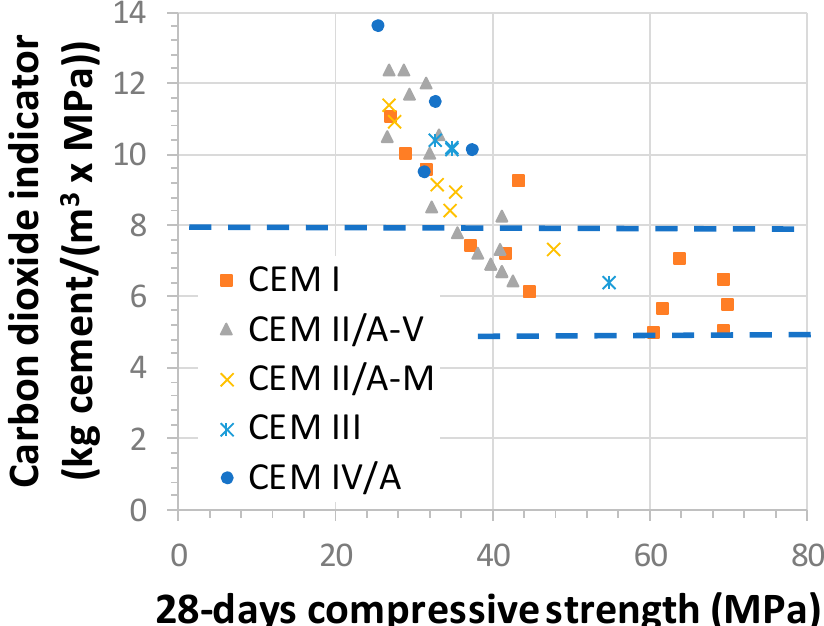
Figure 14. Carbon dioxide indicator, kg cement / (m 3 × MPa), for 40 Spanish commercial concretes.